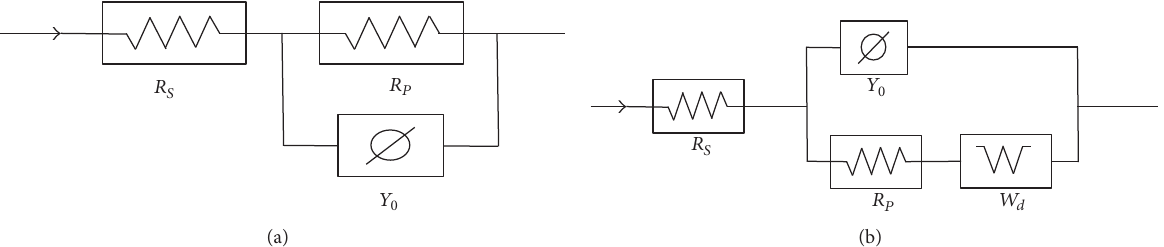
Figure 8: Equivalent circuits models used in the fitting of the impedance data of copper (a) without and (b) with coating in 3.5 wt.% NaCl